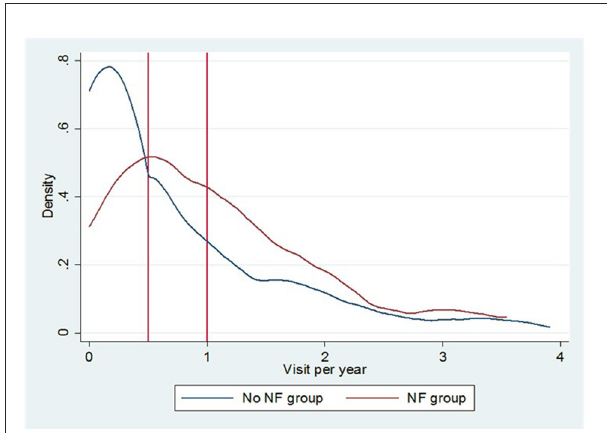
FIGURE1 The Epanechnikov kernel density of annual outpatient visits for GI symptoms in the NF group and the